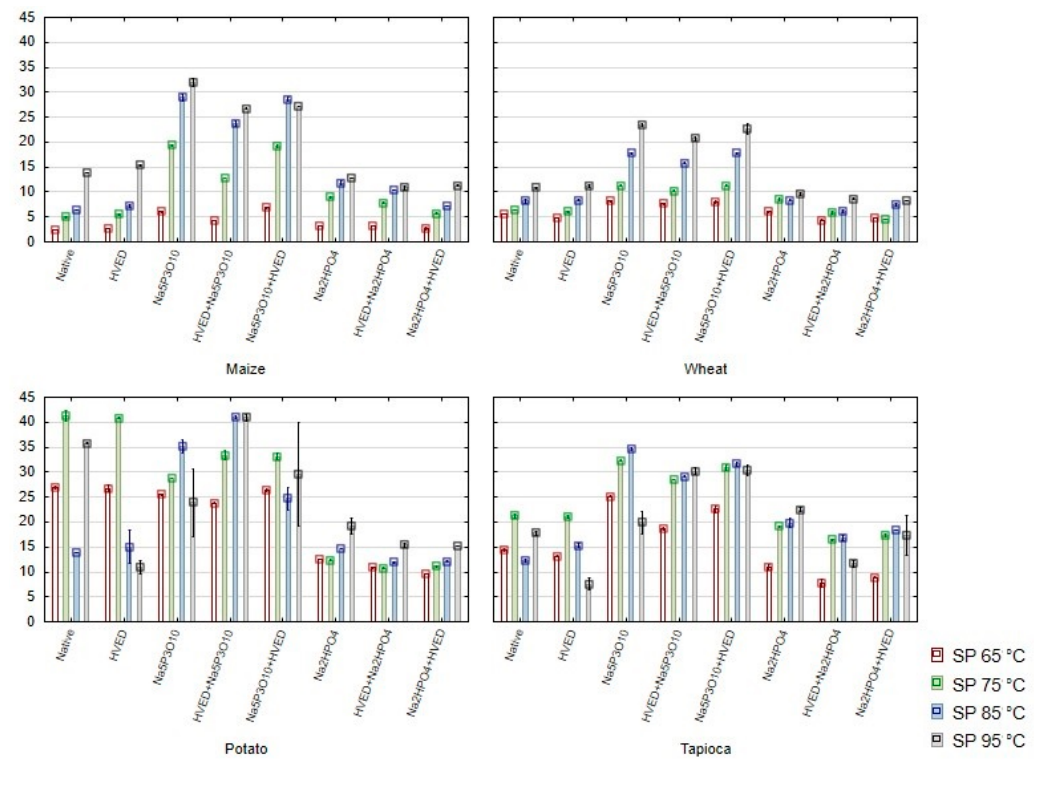
Figure 2. Swelling power (SP) (mean ± 2SD) of starches modified with high-voltage electrical dis- charge (HVED) and phosphorylation.